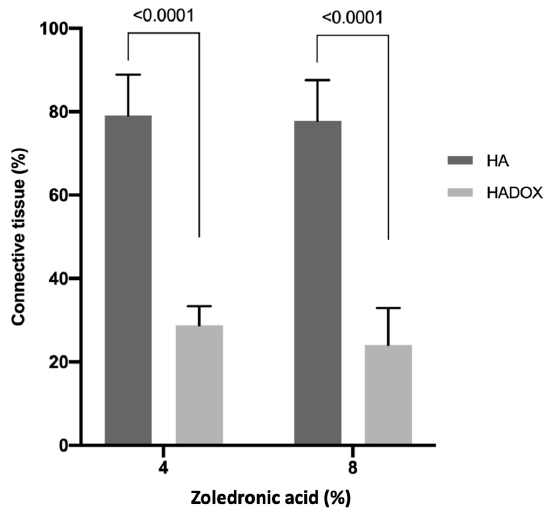
Figure 10. Connective tissue volume density in HA and HADOX groups with 4% and 8% ZA treatment. The values are presented as mean ± C.I. The statistical differences between the groups in the same ZA treatment are represented by horizontal bars. There were no statistical differences ( p > 0.05) between 4% and 8% ZA treatment in the HA and HADOX groups (no difference is represented by the same letter) (Student’s t -test, p >